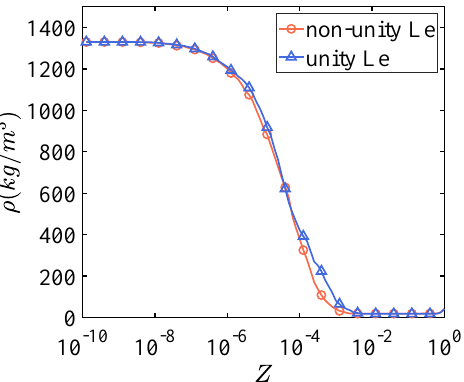
Figure 12. Density distribution in the mixture fraction space for the two